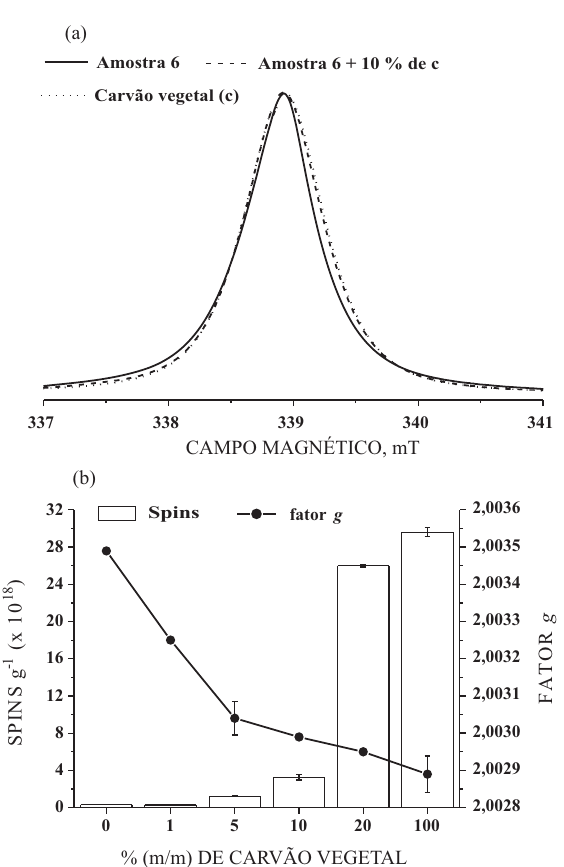
Figura 6. Linhas de absorção normalizadas da amostra 6, da amostra 6 + 10 % (m/m) de carvão vegetal e somente do carvão vegetal (a). Concentração de RLO (em spins g -1 de amostra) da amostra 6 e variação do fator g da amostra 7 de acordo com a porcentagem de carvão vegetal adicionado